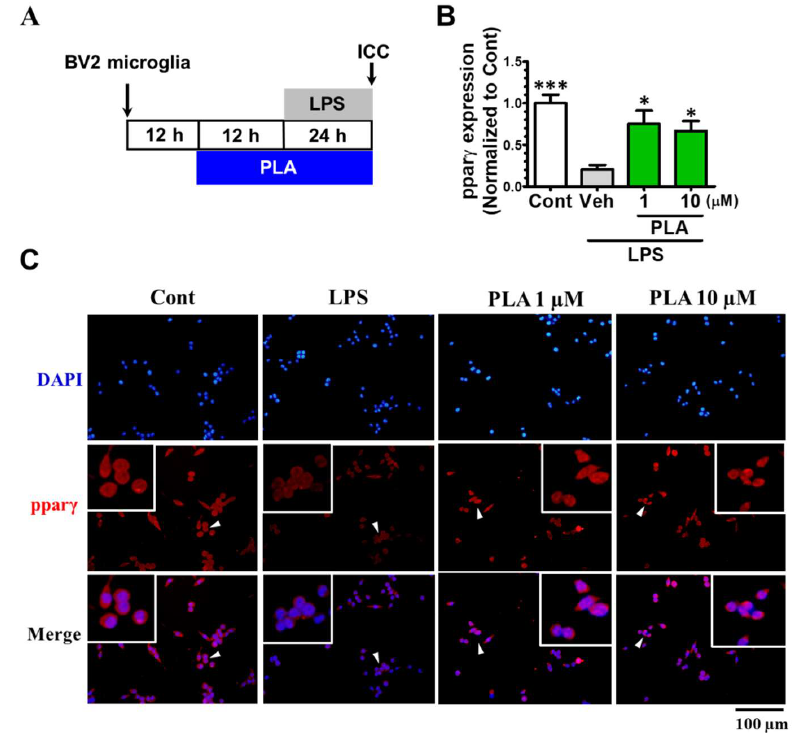
Figure 5. E ff ects of platycodigenin (PLA) on LPS-induced expression of PPAR γ . BV2 microglia were Figure 5. Effects of platycodigenin (PLA) on LPS-induced expression of PPARγ. BV2 microglia were cultured for 12 h and pretreated with PLA (1 and 10 µ M) or control (Cont, 0.1% DMSO) for another 12 h, cultured for 12 h and pretreated with PLA (1 and 10 μM) or control (Cont, 0.1% DMSO) for another followed by stimulation with LPS (100 ng / mL) for 24 h. The cells were fixed and immunostained for 12 h, followed by stimulation with LPS (100 ng/mL) for 24 h. The cells were fixed and immunostained for pparγ. The fluorescent intensity of the pparγ positive cells were measured. ( A ) Experimental ppar γ . The fluorescent intensity of the ppar γ positive cells were measured. ( A ) Experimental schedule. schedule. ( B ) The expression of PPARγ per cell were quantified. ( C ) The representative images ( B ) The expression of PPAR γ per cell were quantified. ( C ) The representative images immunostained immunostained for PPARγ. The data are normalized to the control and shown as the mean ± SEM of for PPAR γ . The data are normalized to the control and shown as the mean ± SEM of three independent three independent experiments. Ten images were captured of each group in the independent experiments. Ten images were captured of each group in the independent experiment. * p < 0.05 and experiment. * p < 0.05 and *** p < 0.001 versus vehicle (Veh), Kruskal-Wallis one-way analysis of *** p < 0.001 versus vehicle (Veh), Kruskal-Wallis one-way analysis of variance by ranks variance by ranks test.